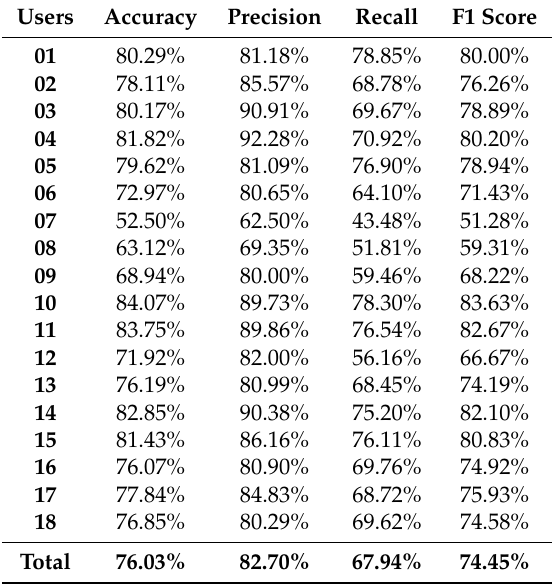
Table 1. Results for each grouped by selected algorithms and